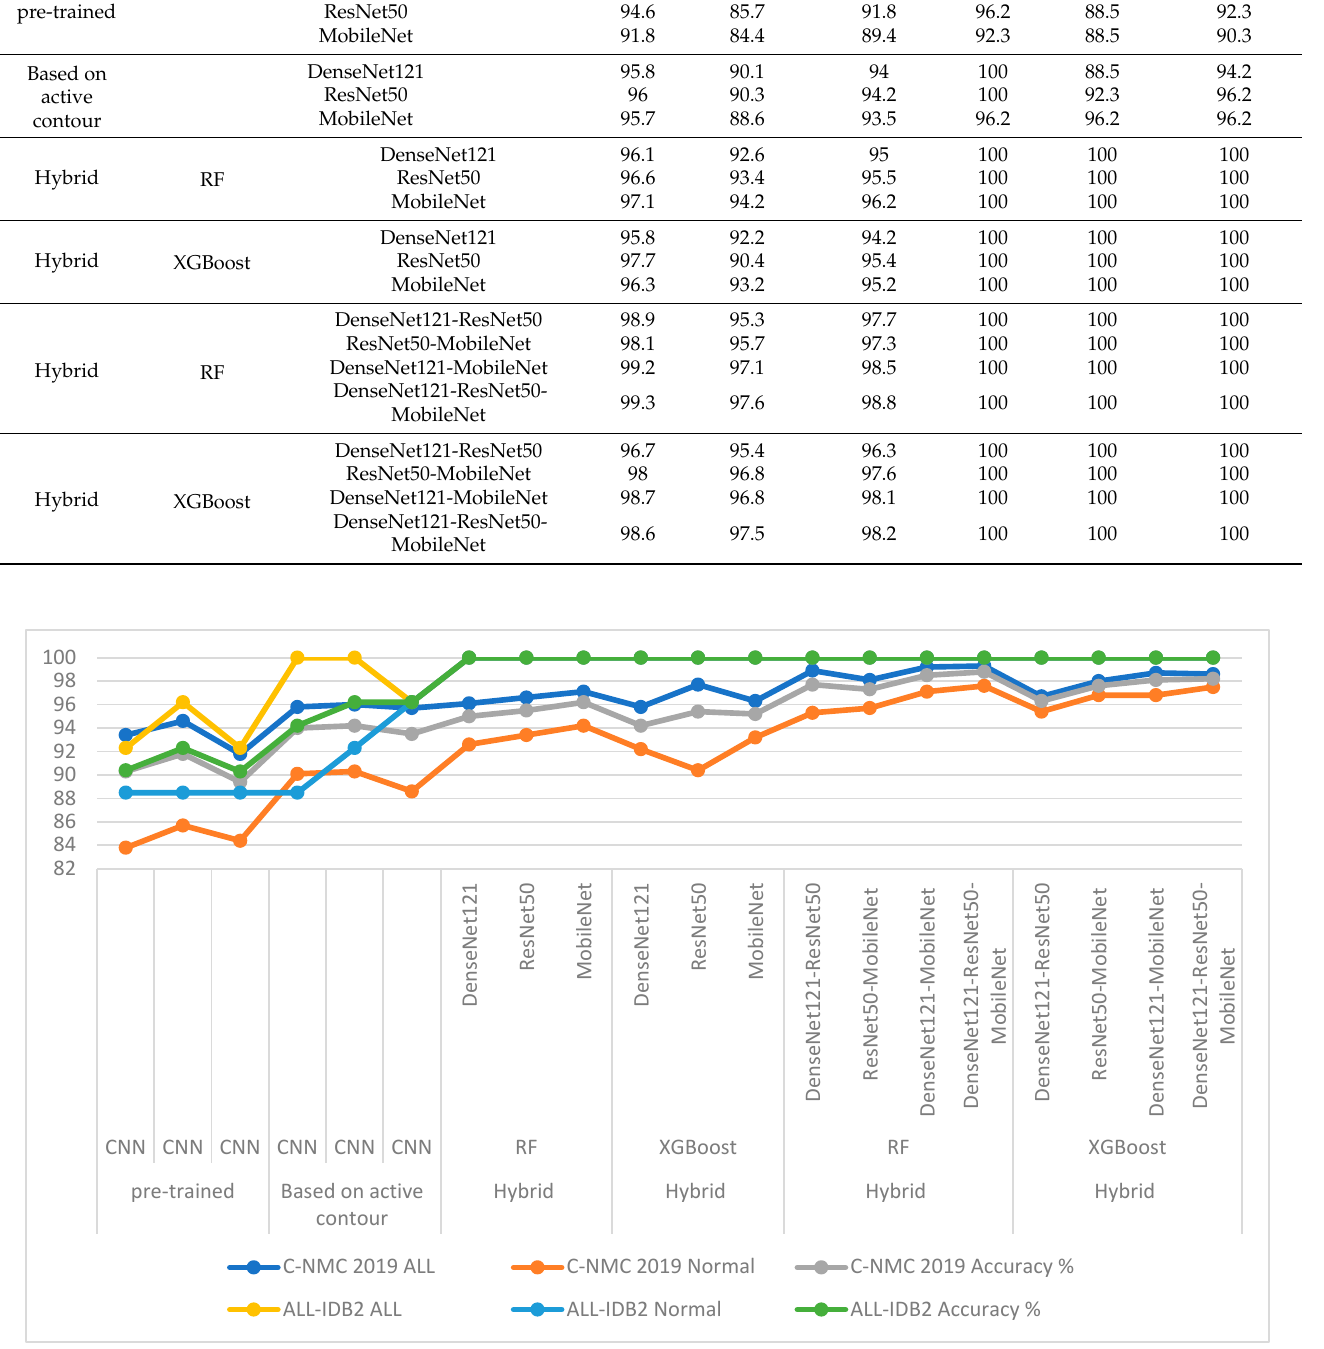
Figure 19. Displaying the results of all systems for the analysis of microscopic blood images for the C-NMC 2019 and ALL-IDB2 datasets acute leukemia at the level of each class .